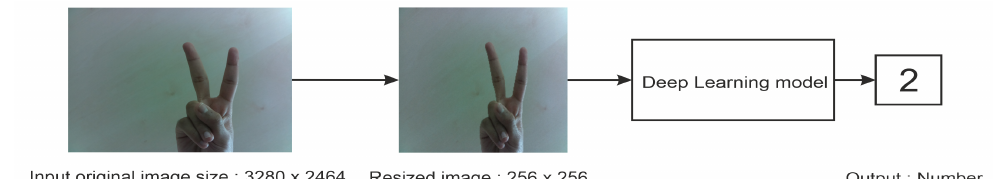
Figure 2. The classification (digit recognition) task used in the proposed end to end system for contactless authentication. The architecture details of the deep learning model are shown in Figure 4 and in Table 5.